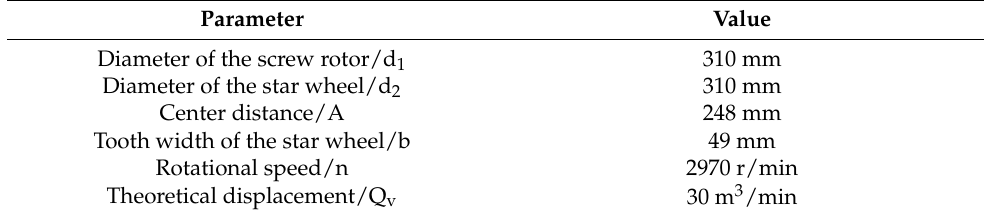
Table 1. Related technique parameters of a WSSC